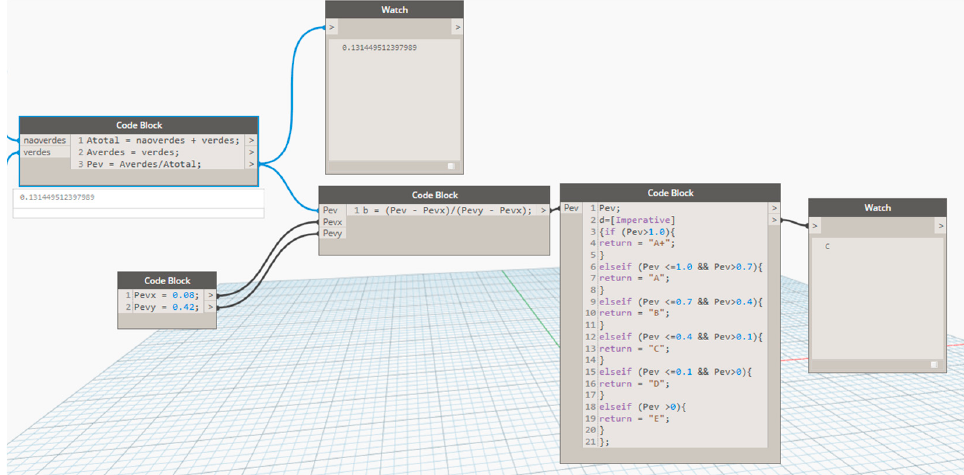
Figure 7. Benchmarks, normalization and qualitative scale.